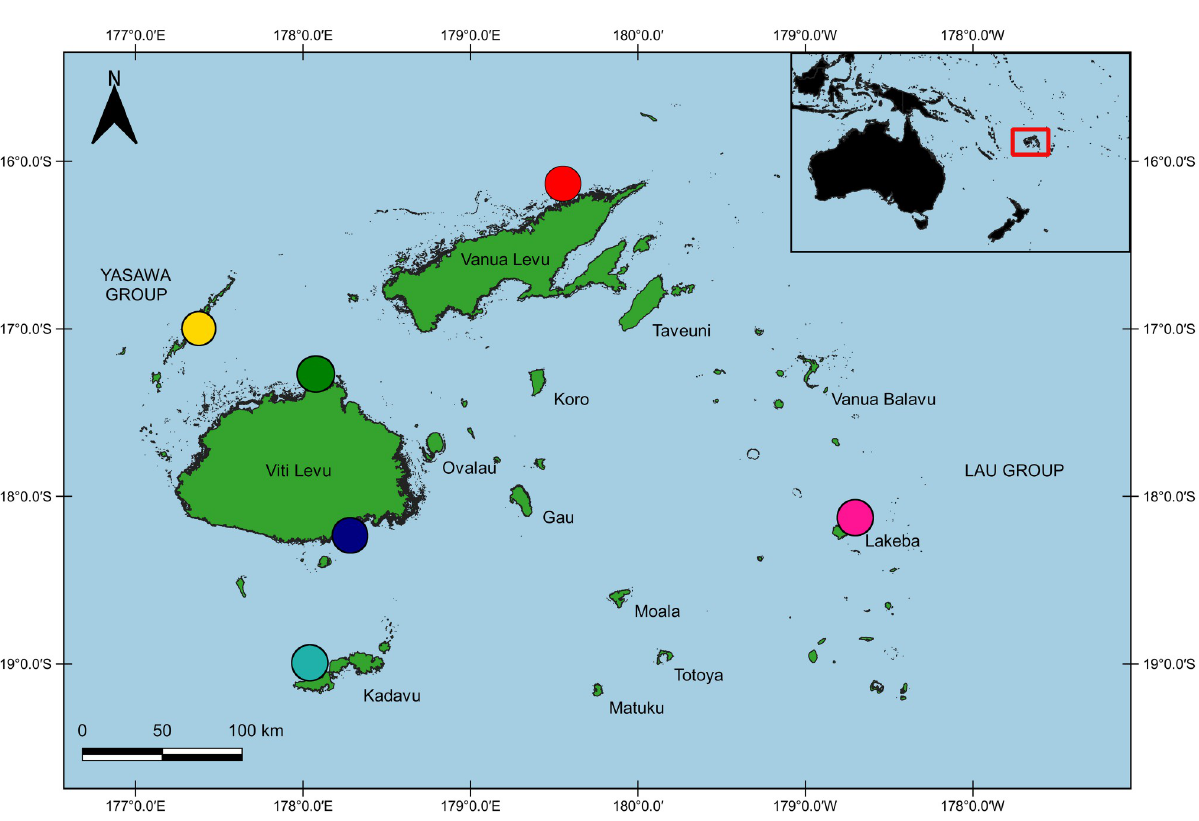
Fig 1. Map of sampling locations in Fiji where Holothuria scabra were collected, adapted from Lal et al. [22]. Dark shading along coastlines represents seagrass bed extents derived from Allen Coral Atlas data (https://allencoralatlas.org). Site codes are as follows: MA, Namuka district, Macuata Province, Vanua Levu; LA, Lakeba island, Lau island archipelago, Lau Province; KA, Tavuki district, Kadavu island, Kadavu Province; SA, Serua island, Serua Province; RA, Raviravi district, Ra Province, Viti Levu; YA, Nacula island, Yasawa island archipelago in the Ba Province. Produced using QGIS v 3.14.16-Pi and open source geographical data obtained from the SPC Pacific data hub (https://pacificdata.org/).